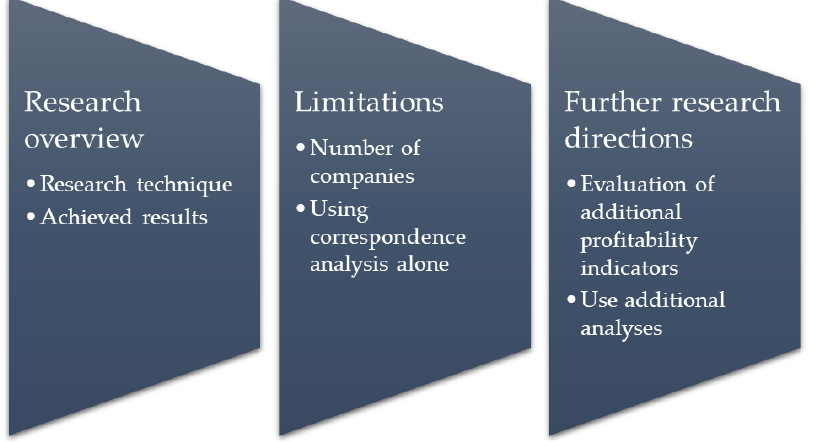
Figure 15. Structure of the conclusion. Source: own research .